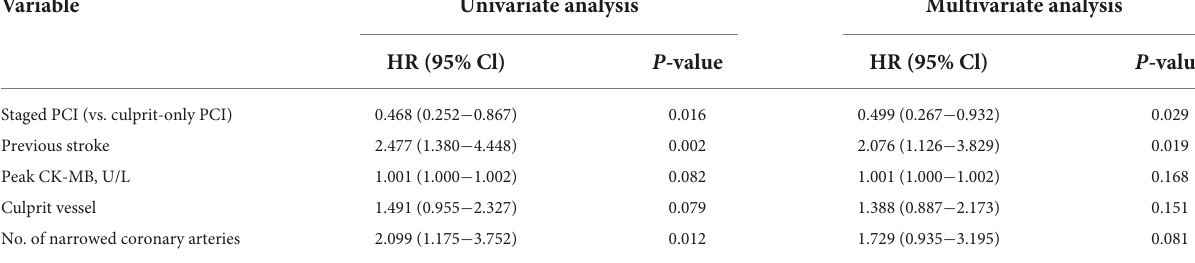
TABLE 6 Cox proportion hazards analysis for predictors of the MACCE after PSM analysis.